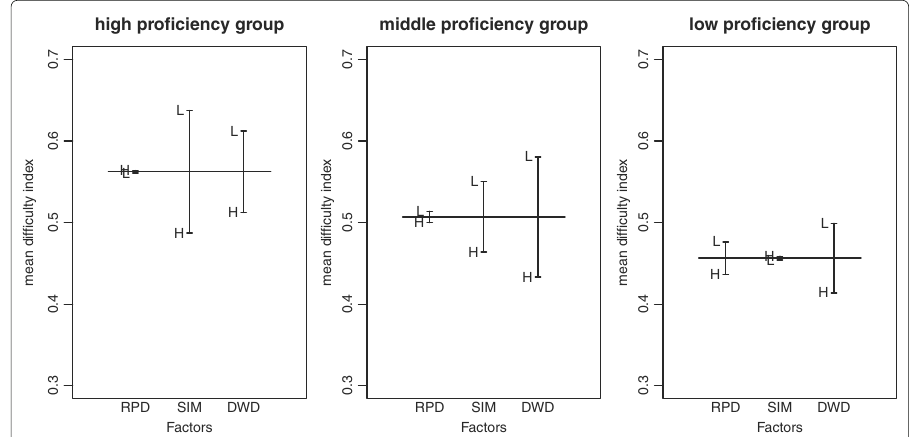
Fig. 4 Differences of mean difficulty index across proficiency-based